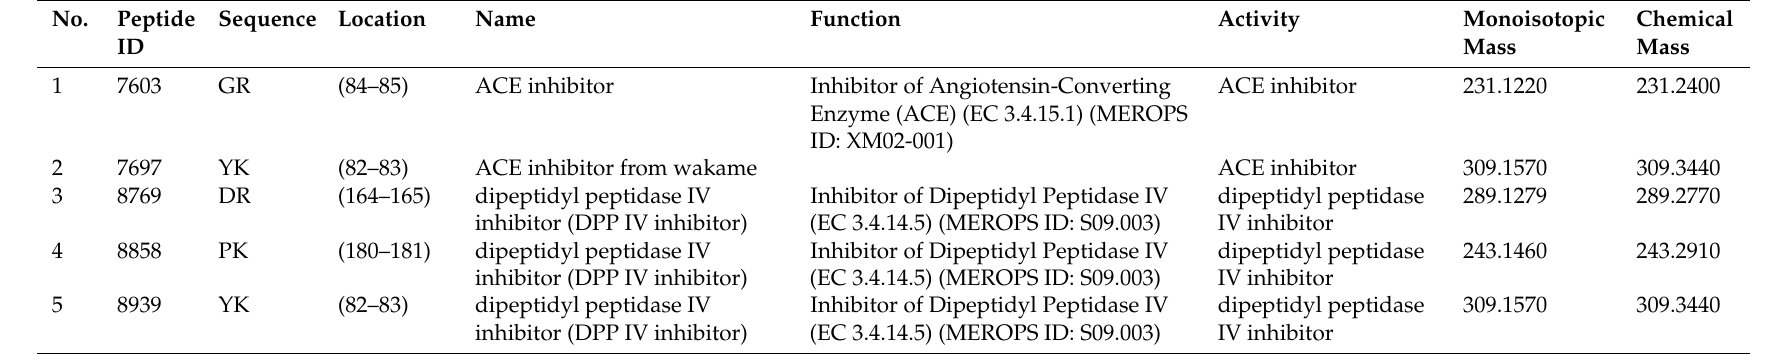
Table A39. Bioactive peptides from RubisCO of Halophila stipulacea . In silico enzymatic cleavage was carried out by using oligopeptidase B.